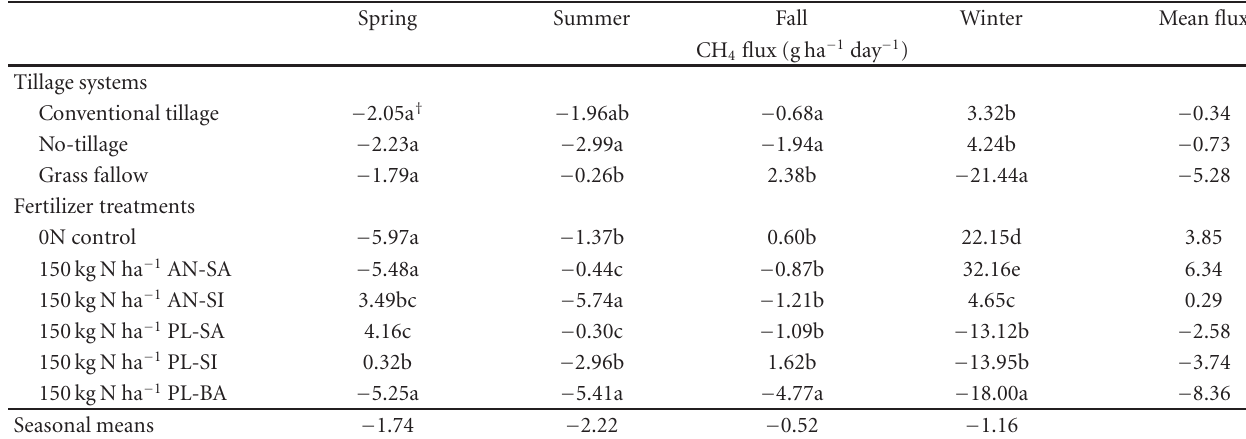
Table 3: Soil methane fluxes as influenced by tillage systems and ammonium nitrate (AN) and poultry litter (PL) N fertilizers using surface (SA), soil incorporation (SI), and subsurface band (BA) application methods in spring, summer, fall, and winter seasons, Hazel Green, Alabama.